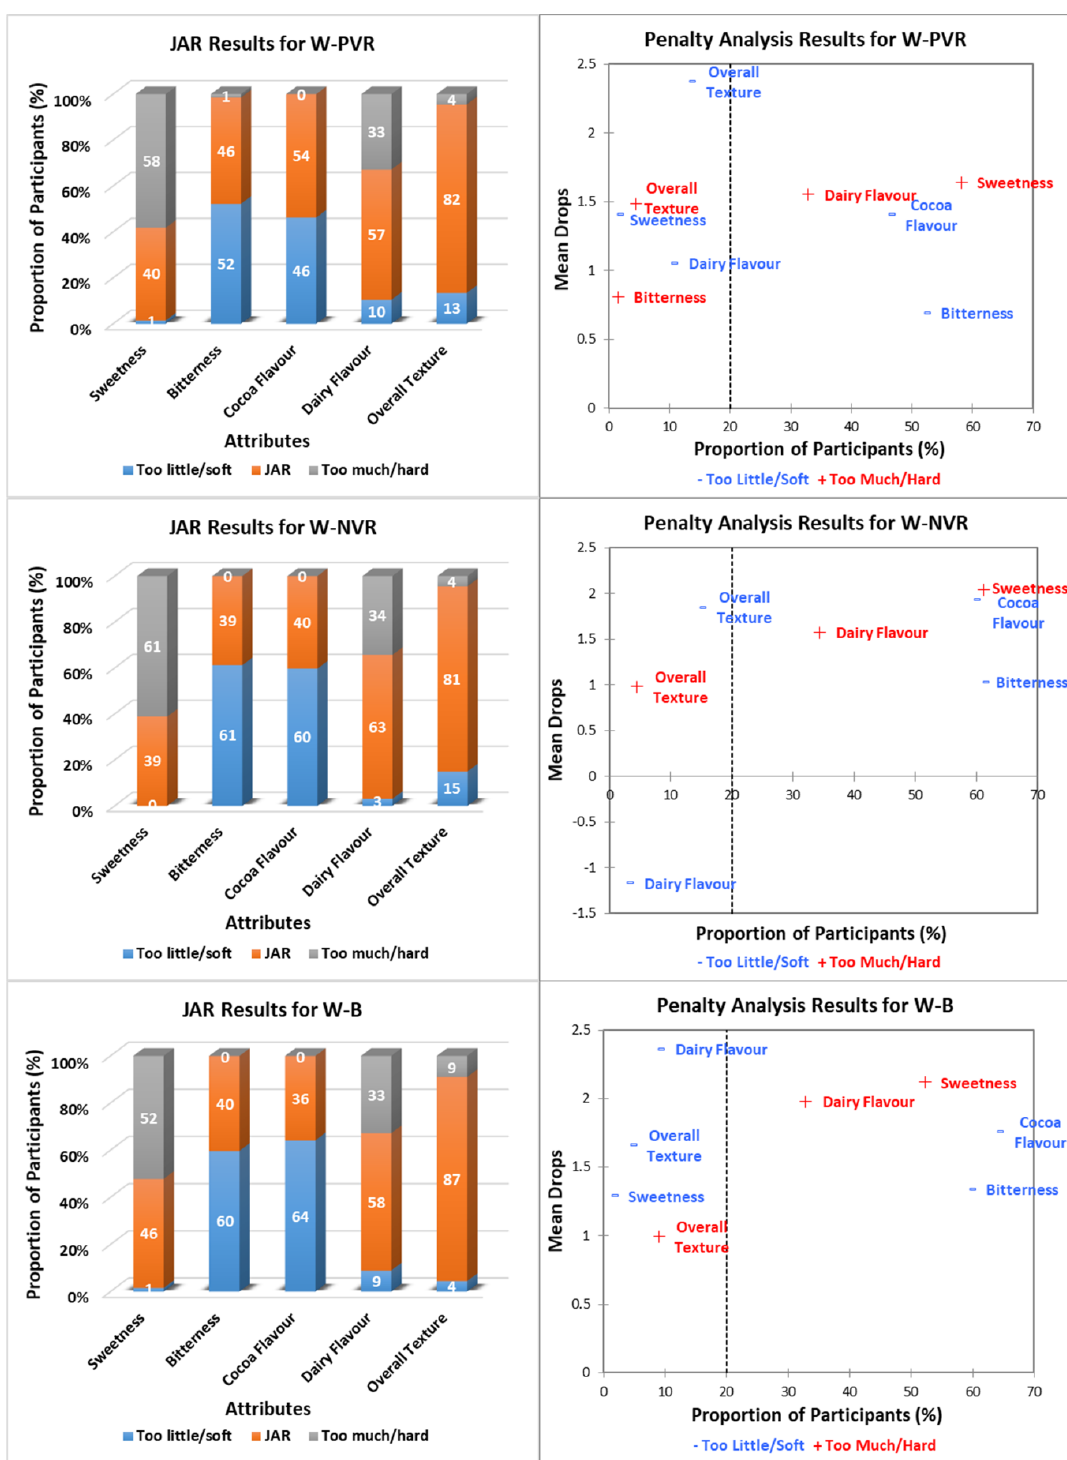
Figure 4. Just-About-Right (JAR) frequencies and penalty analysis results 1 regarding white chocolate attributes under different environments 2 . 1 Penalty analysis was associated with the overall liking scores (9-point hedonic scale). 2 W-PVR: white chocolate positive VR; W-NVR: white chocolate negative VR; W-B: white chocolate sensory booth.